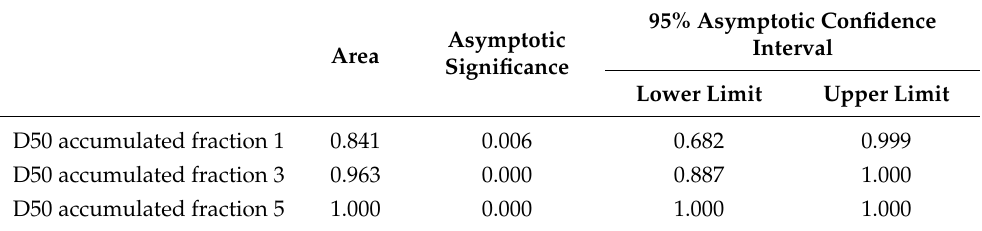
Table 1. Area under ROC curves and significance for accumulated D50 in first fractions and compli- ance with the R50.